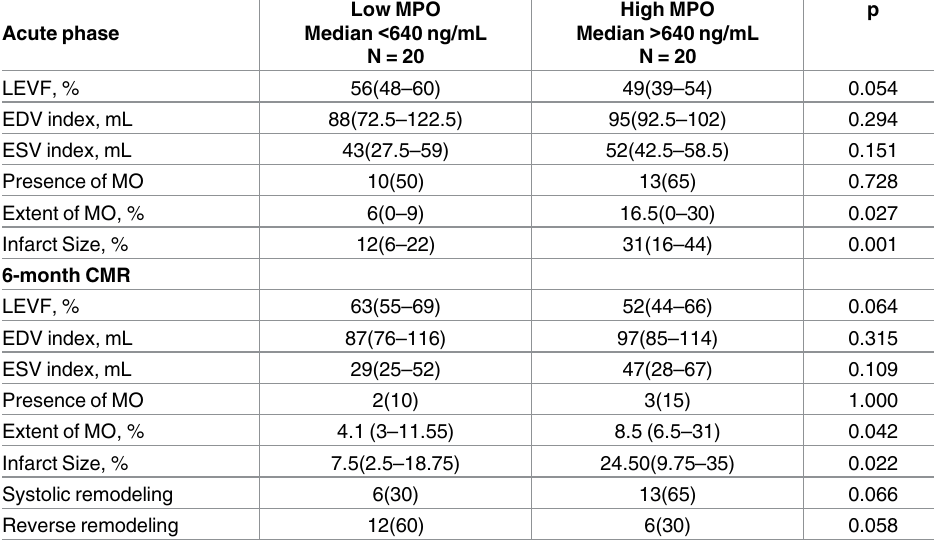
(Table 1). Nitric oxide bio-availability assessed by the L-arg/ADMA ratio at the culprit lesion site, showed that there was no difference for this parameter between the low and high-MPO group. However, patients with high MPO levels had a higher plasma HDL level (0.47 mmol/L vs. 0.38 mmol/L). Table 2. CMR data at acute phase and at 6